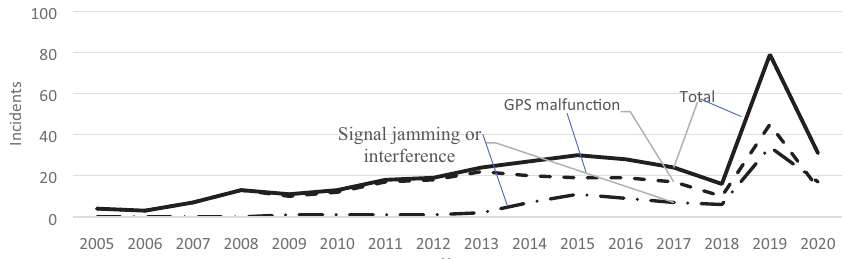
Figure 1. Incidents caused by GNSS malfunction, signal jamming, and interference